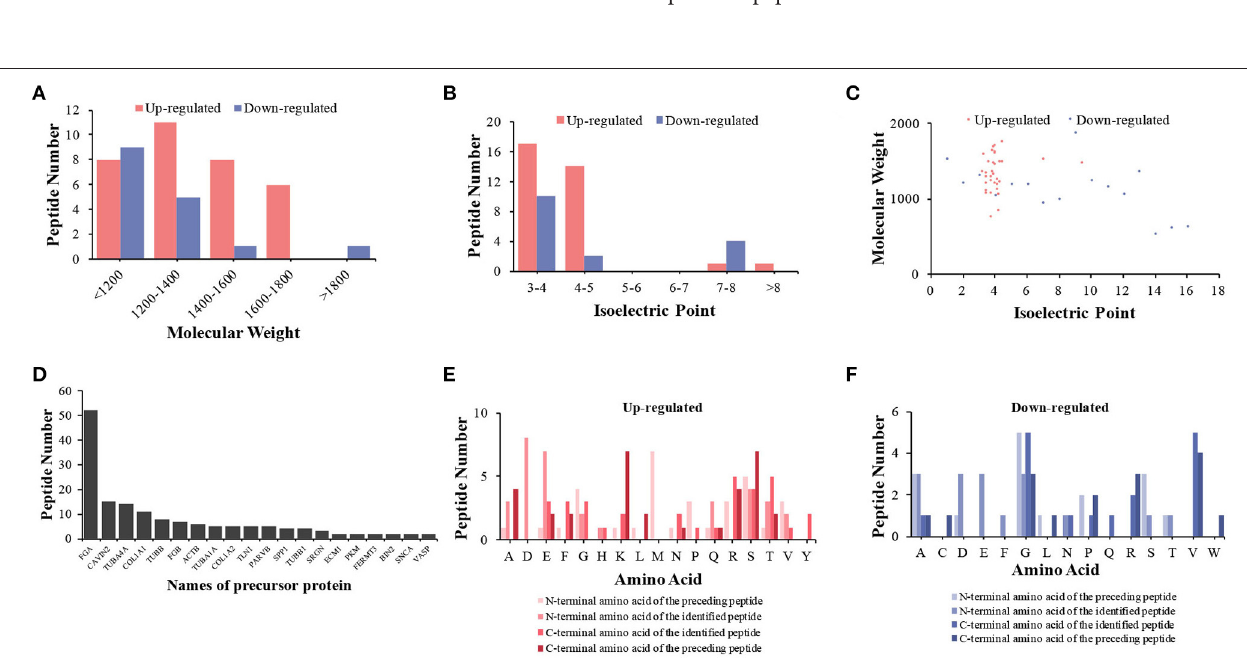
FIGURE 3 | Features and cleavage patterns of differentially expressed peptides. Molecular weights of upregulated and downregulated peptides (A) . Isoelectric points of upregulated and downregulated peptides (B) . Scatter plot of isoelectric point vs. molecular weight in upregulated and downregulated peptides (C) . Peptide numbers for each protein precursor (D) . Distribution of the cleavage sites in upregulated peptides (E) . Distribution of the cleavage sites in downregulated peptides (F) .